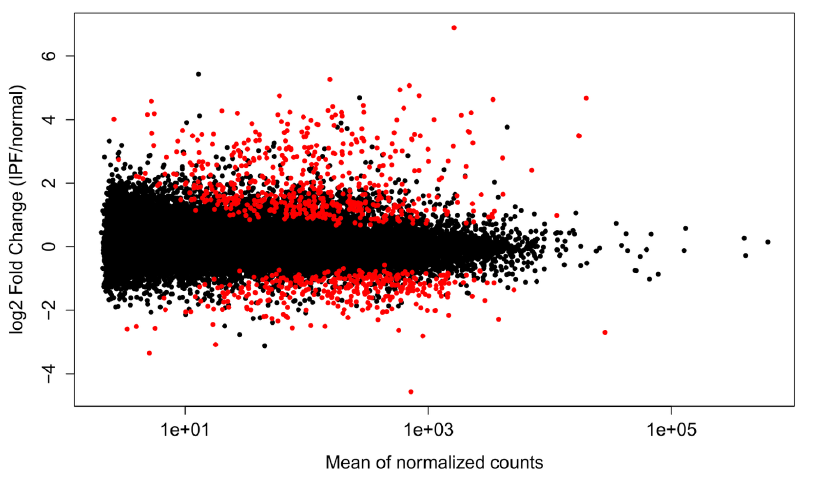
Figure 1. Differential expression analysis reveals more upregulation than down regulation. This plot depicts fold change vs. mean expression. Points depict genes, with red indicating those genes that show significant differential expression (FDR , 5%).